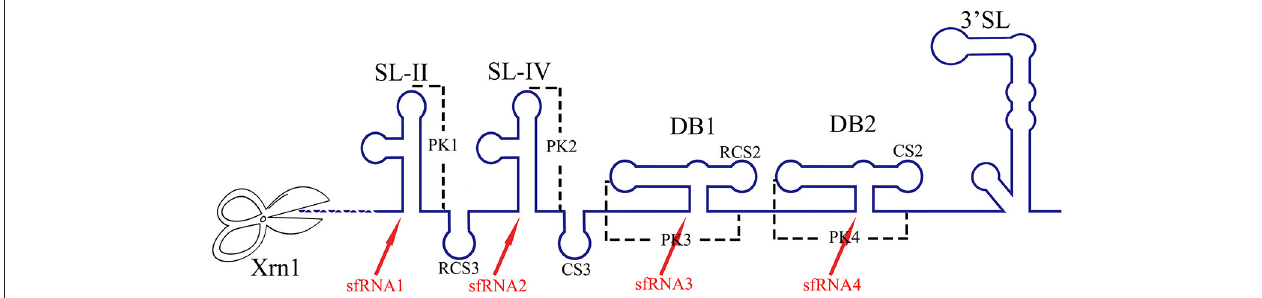
FIGURE 7 | The biogenesis of sfRNA in WNV-infected cells. The primary sequences (RCS3, CS3, RCS2, CS2) and higher order structures (SL-II, SL-IV, DB1, DB2, PK1, PK2, PK3) of the WNV 3 ′ UTR are required for production of sfRNAs (Pijlman et al., 2008; Funk et al., 2010; Zhang et al.,